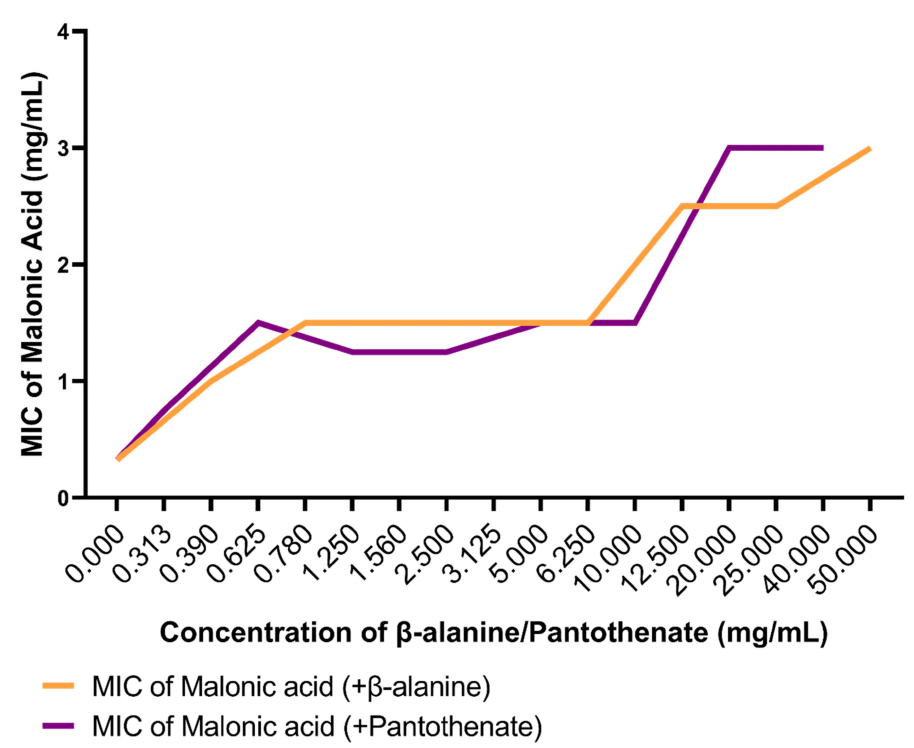
Figure 9. A chart representing the in vitro confirmation of aspartate 1-decarboxylase selective inhibition by malonic acid through showing the MIC of malonic acid against A. baumannii ATCC 19606 after the addition of increasing sub-inhibitory concentrations of the byproducts of the reaction catalyzed by aspartate 1-decarboxylase, β -alanine (orange line) and pantothenate (purple